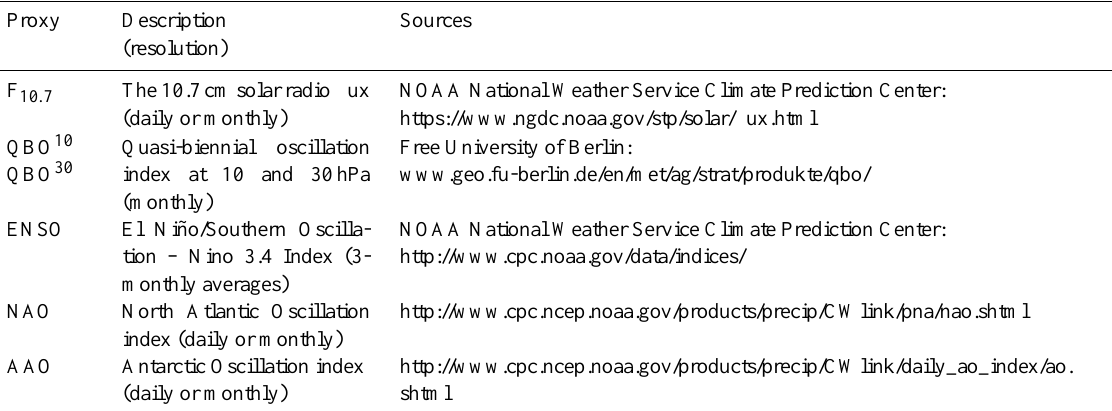
Figure 2. Distributions of (a) O 3 columns, (b) DOFS and (c) a priori contribution (given as a %) in the ground–300hPa (MLT) and 150– 25hPa (MLST) layers for IASI O 3 , averaged over July 2010 daytime data. Note that the scales are different. Table 1. List of the proxies used in this study and their